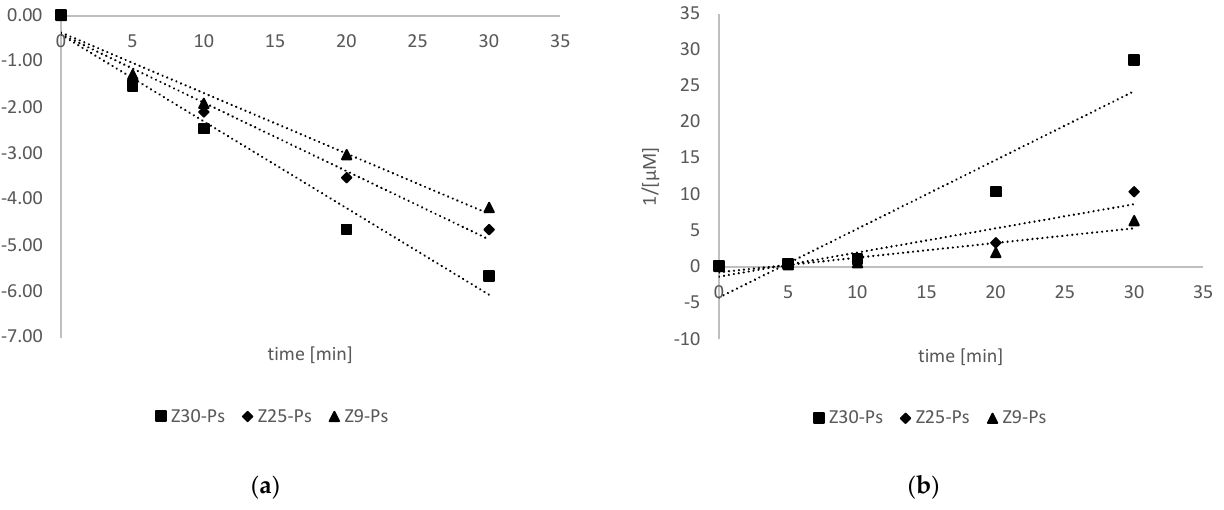
Figure 4. Fitting of the experimental data for Z30-Ps, Z25-Ps and Z9-Ps following the first-order ( a ) and the second-order ( b ) equations. The first-order law better fit the experimental data.